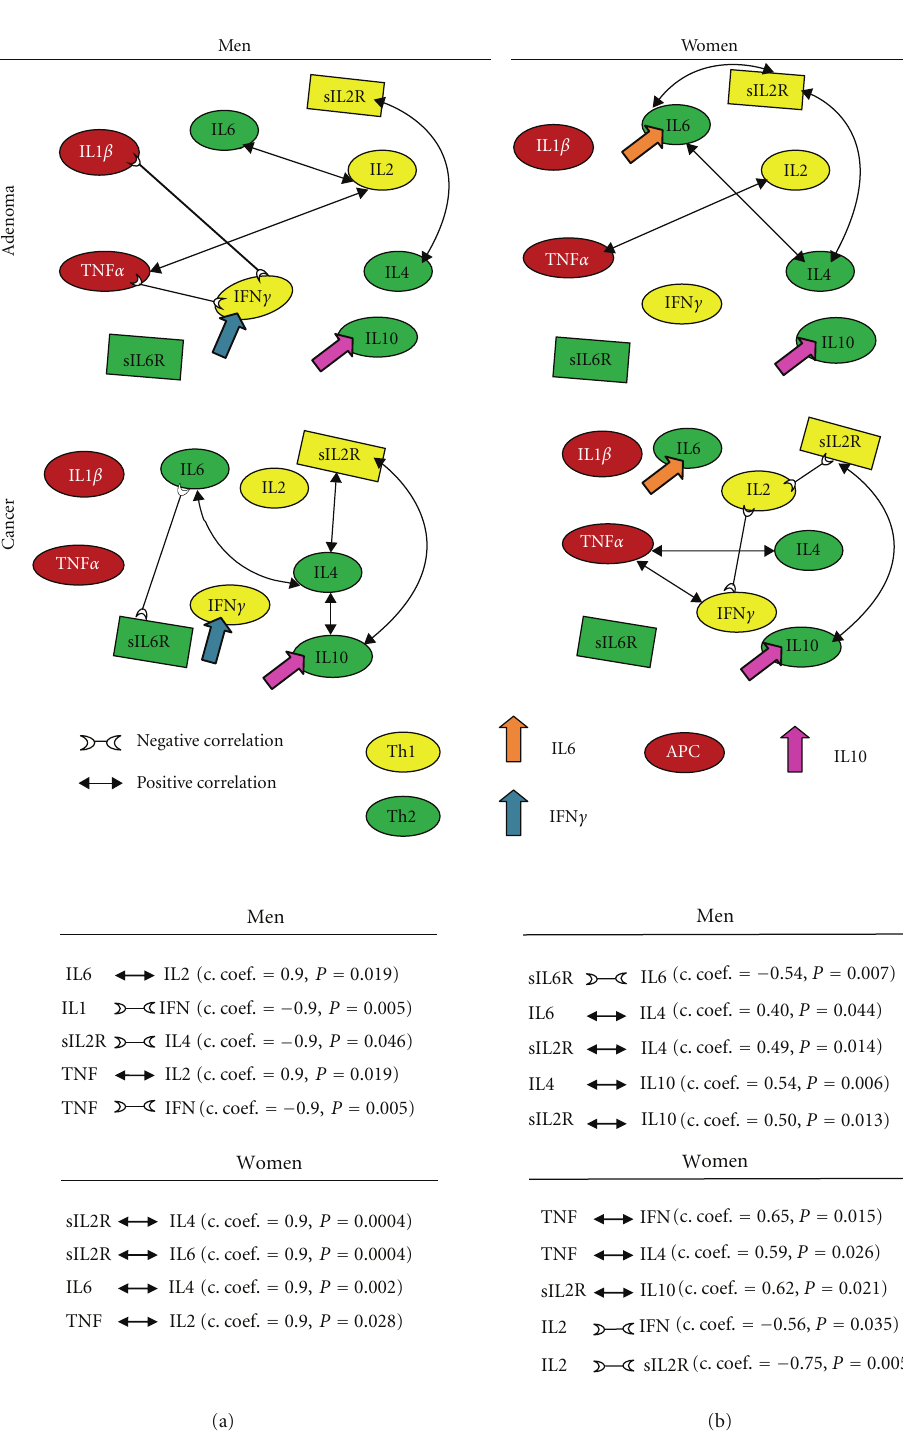
Figure 3: In adenoma patients (a), gender-specific pathways partially regulate Th1 and Th2 cell network homeostasis. In neither sex was a significant relationship observed between IL10 and other Th1/Th2 network components. IFN γ and IL6 pathways (in men and women, resp.) still regulate, albeit partially, the sex-specific Th1 and Th2 cell network homeostasis (and so the immune response) in adenoma patients; in neither sex was a significant relationship observed between IL10 and other Th1 and Th2 network cytokines. No significant relationships for IFN γ or IL6 (in men and women, resp.) were observed in colorectal cancer patients (b), indicating alterations in the gender-specific regulatory pathways responsible for Th1/Th2 physiological homeostasis. The persistence of IL10 within the environmental network is a significant biomarker for the loss of Th1 and Th2 cell network homeostasis and disease progression in both men and women, mediated however through di ff erent sex-related Th1/Th2 pathways. In normal immune response the influence of IL10 on Th polarization is short- lived in both